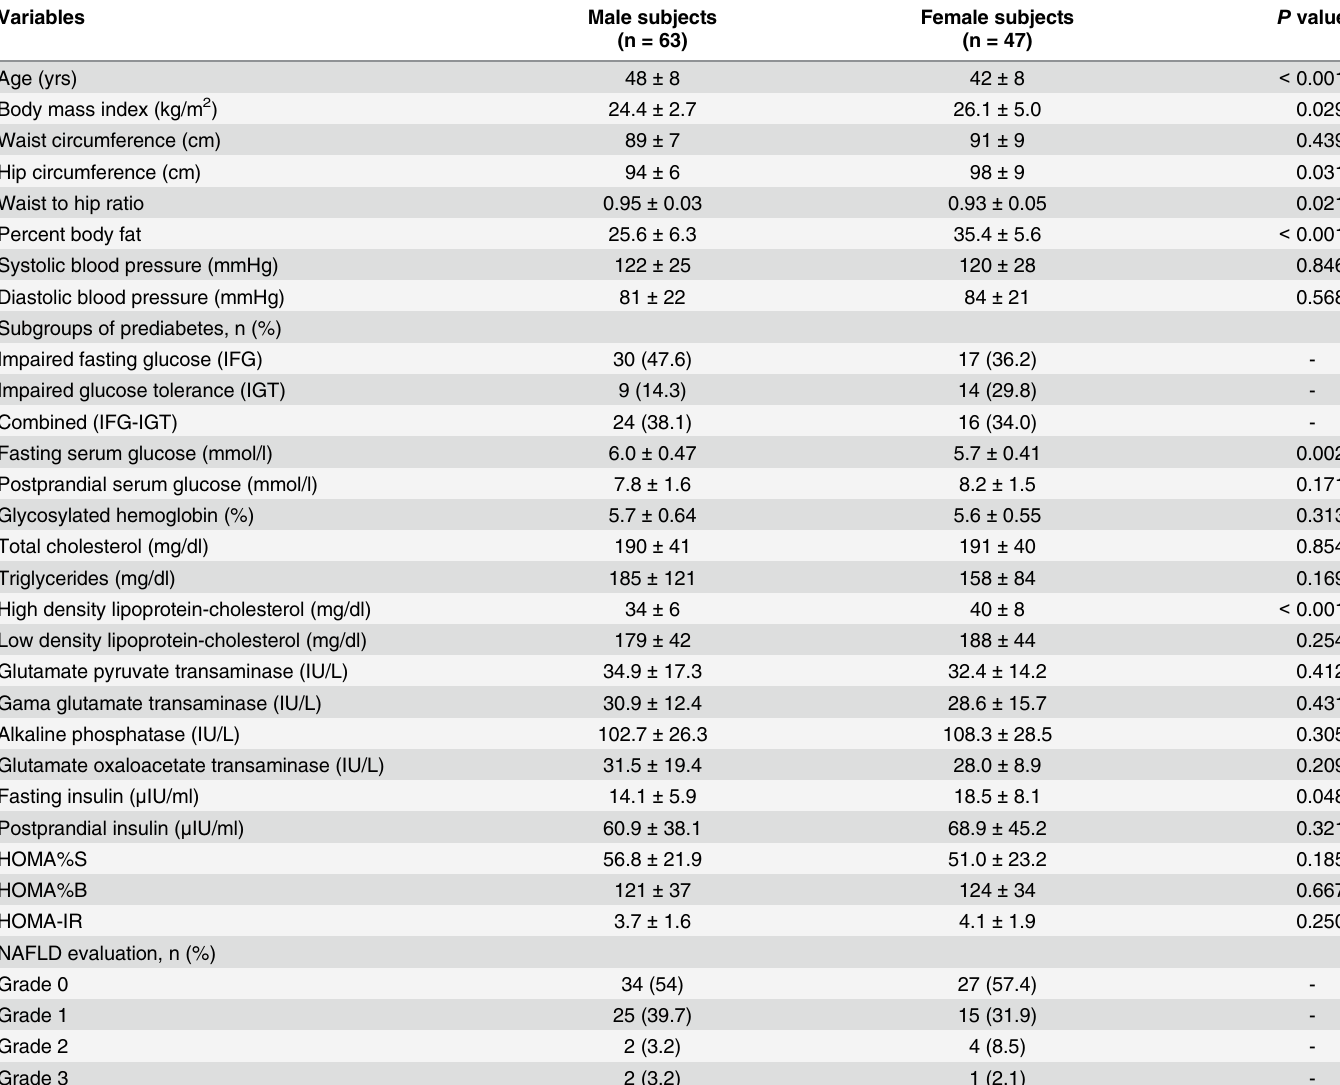
Table 1. General characteristic of the study subjects by